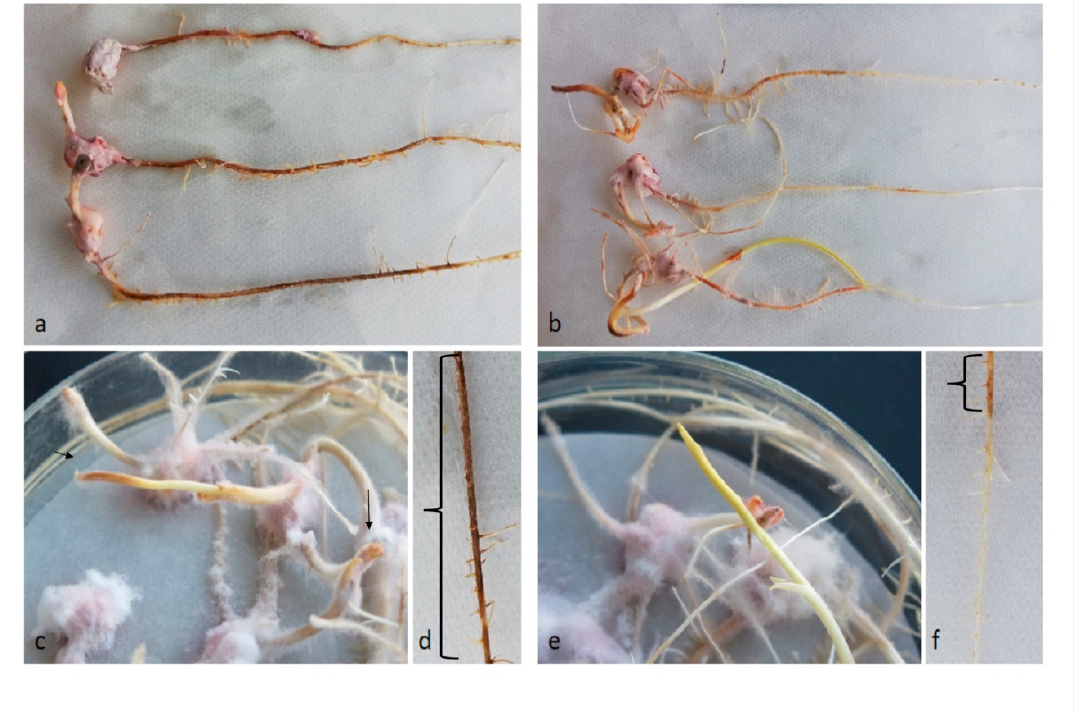
Figure 1 . Seedling shoots and roots showing necrotic areas caused by infection with Fusarium verticillioides wild-type (wt) or fum1 deletion mutant ( fum1 Δ ) strains. ( a ) wt and ( b ) fum1 ∆ infected seedlings at 14 days after infection (dai); close view of typical shoots and the necrotic portion of the roots in wt-( c , d ) and in fum1 ∆ infected seedlings ( e , f ) with (the necrotic areas are indicated by the arrows – in the shoots – and between brackets – in the roots).